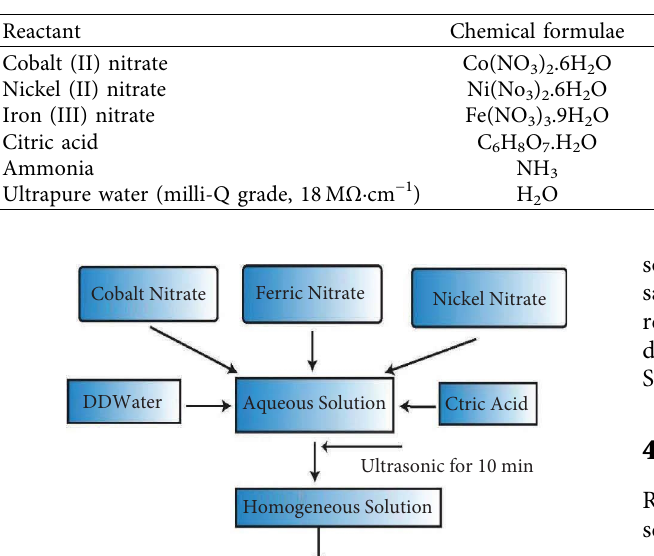
Table 1: Chemicals and reagents.